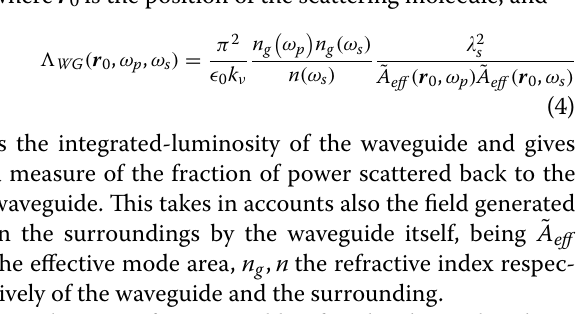
Fig. 3 Theoretical conversion efficiency curves for slot waveguides for a Si 3 N 4 core with λ 0 with λ 0 1550 nm. The solid lines: TE polarized excitation and collection. Dashed lines: TM polarized excitation and collection. Green, magenta and = red lines are respectively for slot width of 150 nm, 50 nm and 10 nm. Only the curve segments corresponding to single mode operation from the cut-off width are shown. (Reprinted with permission from Ref.